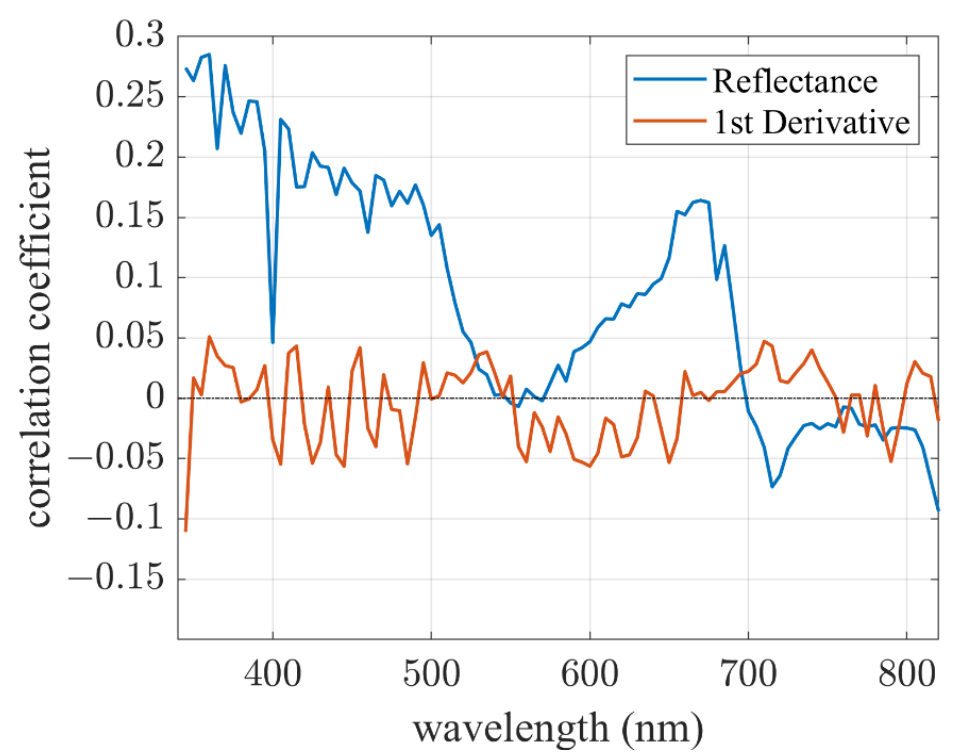
Figure 6. Correlation test between sap flux density and spectra (reflectance and the 1st order de- rivative spectra) at each wavelength.